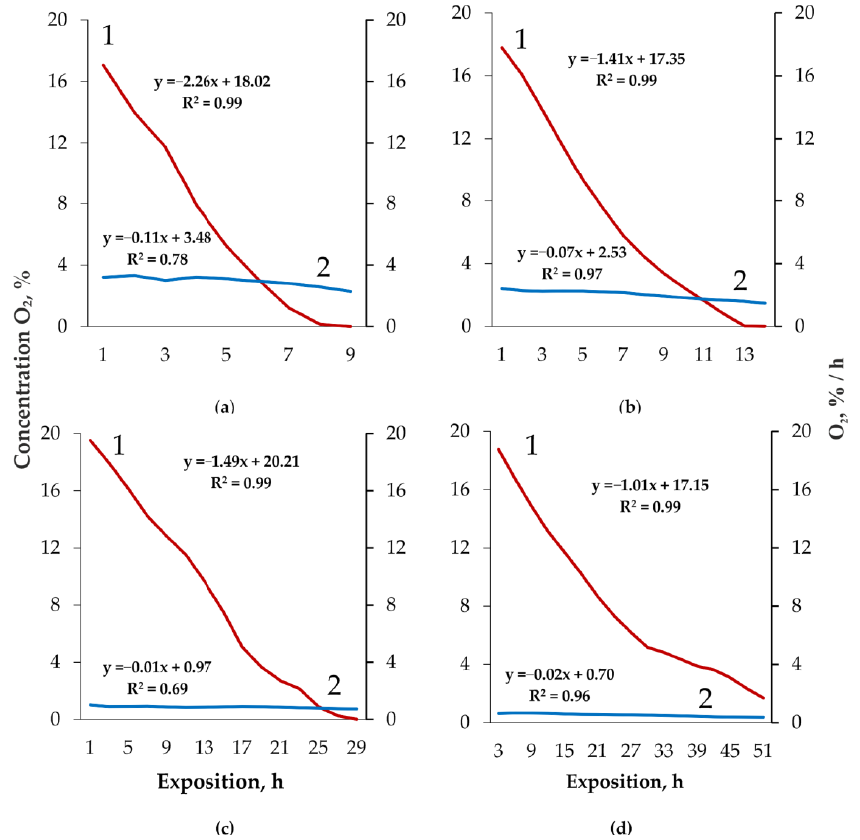
Figure 3. O 2 concentration (1) and intensity of its consumption (2) by Fomes fomentarius ( a ), Fomitopsis pinicola ( b ) basidiocarps and Fomes fomentarius ( c ), Fomitopsis betulina ( d ) substrates. R 2 —coefficient of determination.